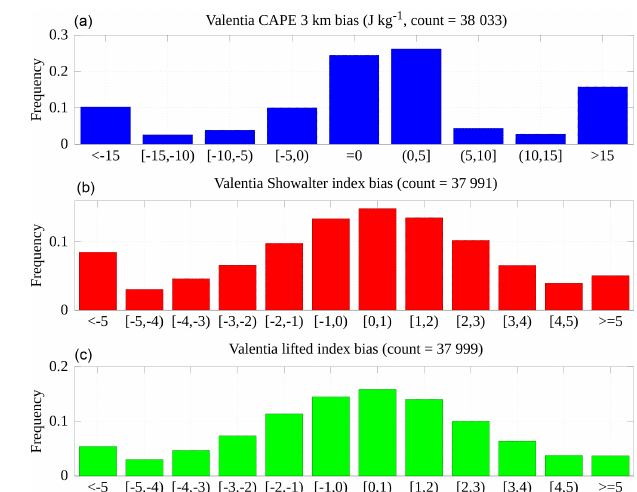
Figure 12. Error distributions for three COSMO-CLM parameters, found through comparison with Valentia radiosonde data. (a) Cape 3km. (b) Showalter index. (c) surface lifted index.